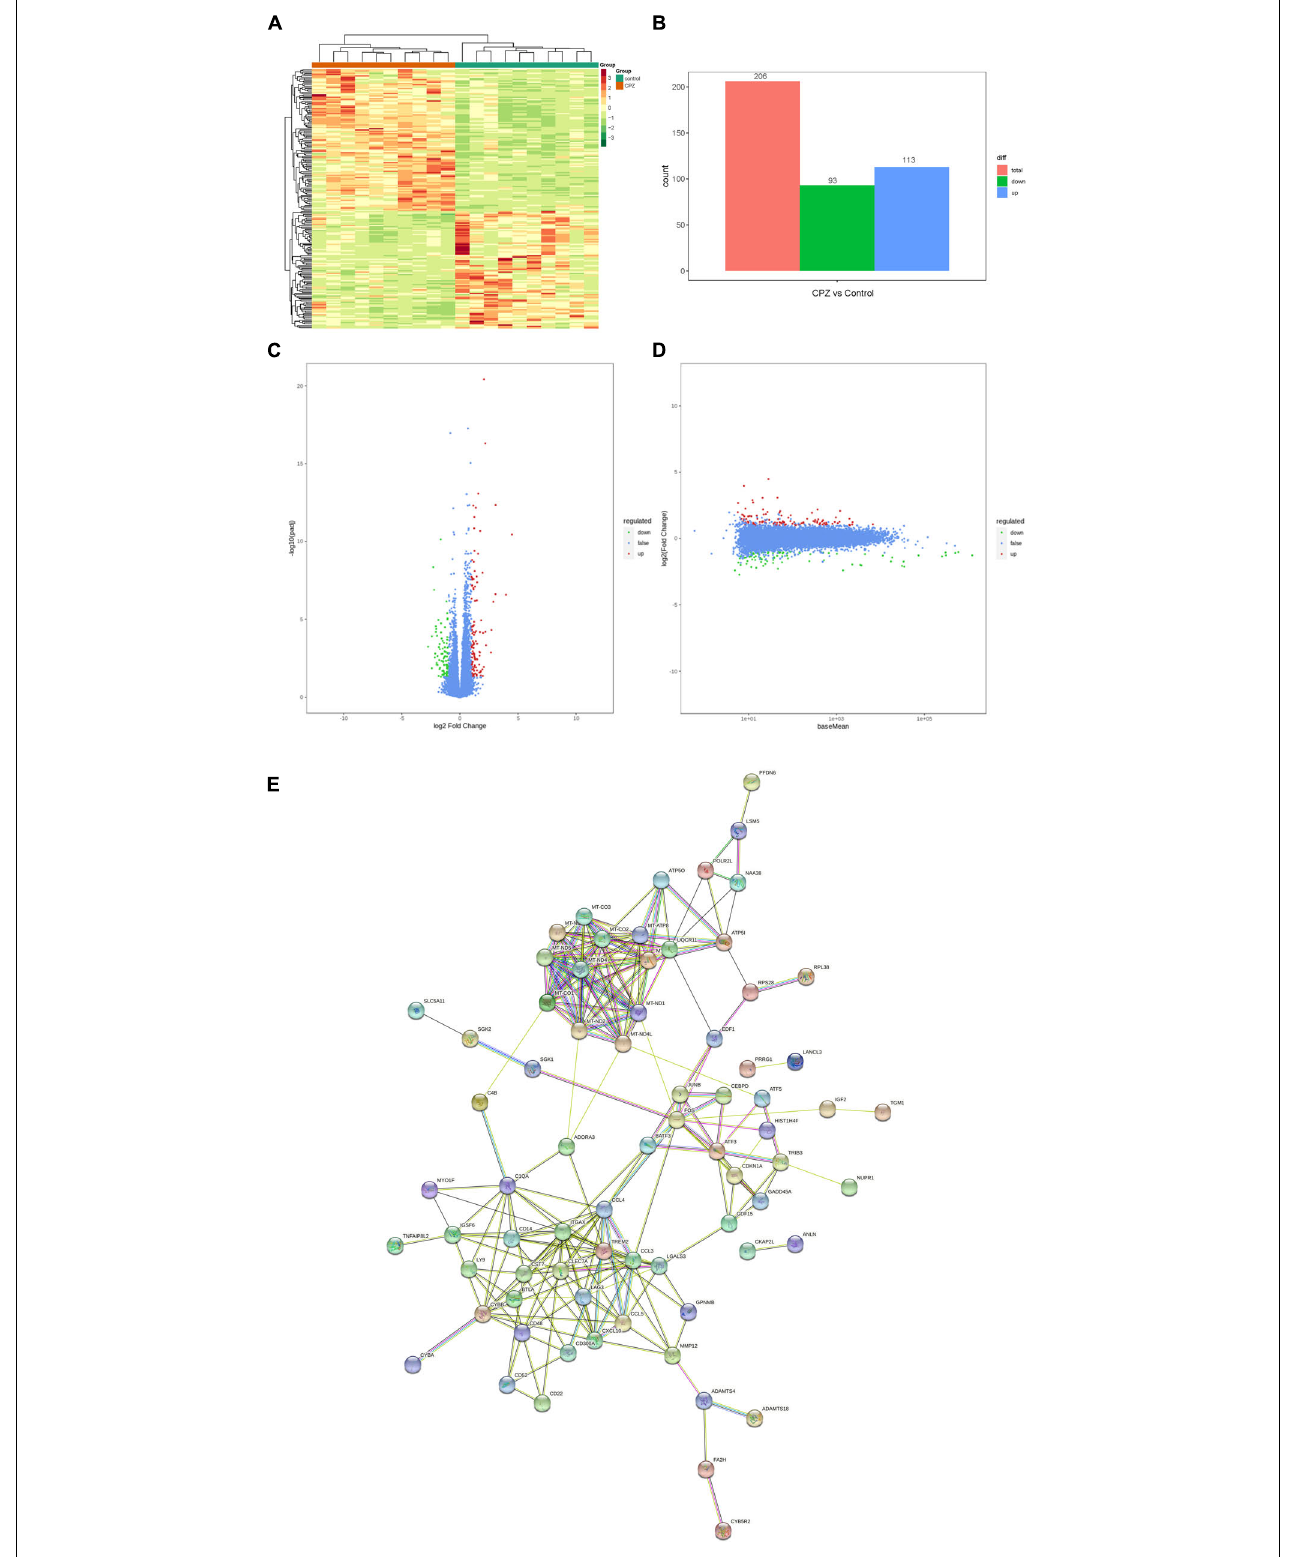
FIGURE 8 | (A) Clustering heat map of FPKM. (B) Histogram of differential genes’ statistic. (C,D) Volcano map and M-vs.-A plot of all genes. (E) Differential genes protein interaction network.